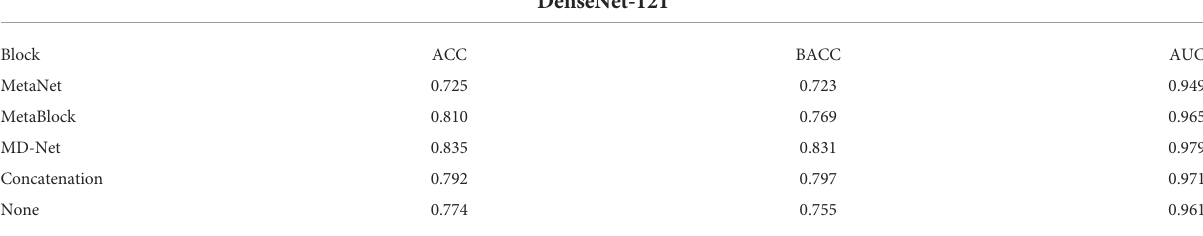
TABLE 9 Compare the performance of DenseNet-121 network fusing different modules on the ISIC 2019 dataset. HIGHEST AVERAGE BACC FOR EACH MODEL.